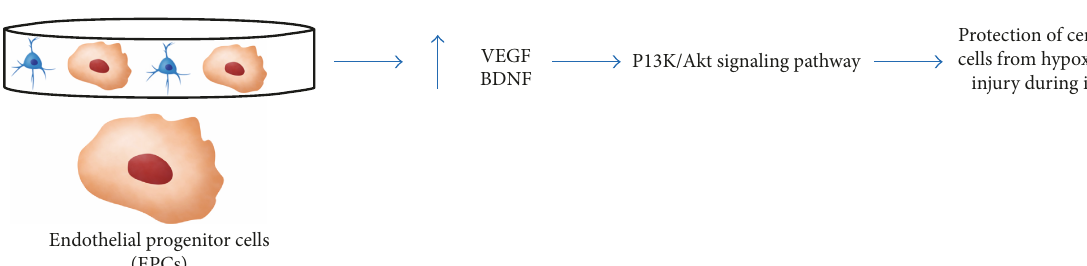
Figure 7: This fi gure demonstrates the e ff ects of using cotransplantation as a method for stem cell therapy. An example of this approach is using endothelial progenitor cells (EPCs) and NSCs. Together, they create a synergistic e ff ect that results in an increase in VEGF and BDNF. This activates the PI3K/Akt pathway that is thought to protect cerebral endothelial cells from hypoxia/reoxygenation injury during ischemic